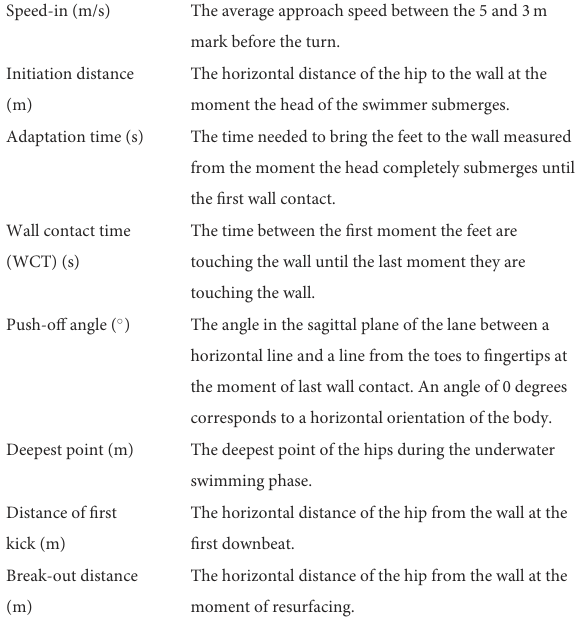
TABLE 1 Operational definition of the variables of